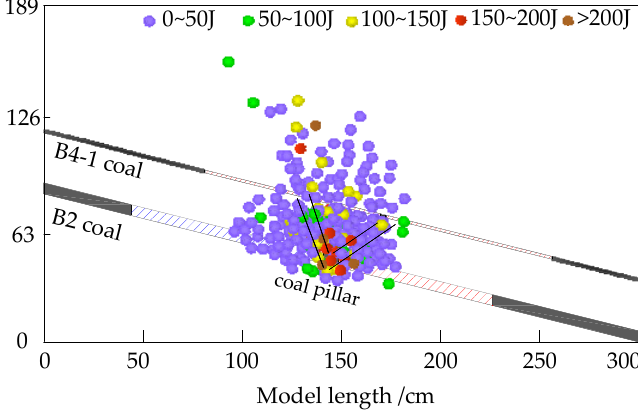
Figure 13. Distribution characteristics of MS events.